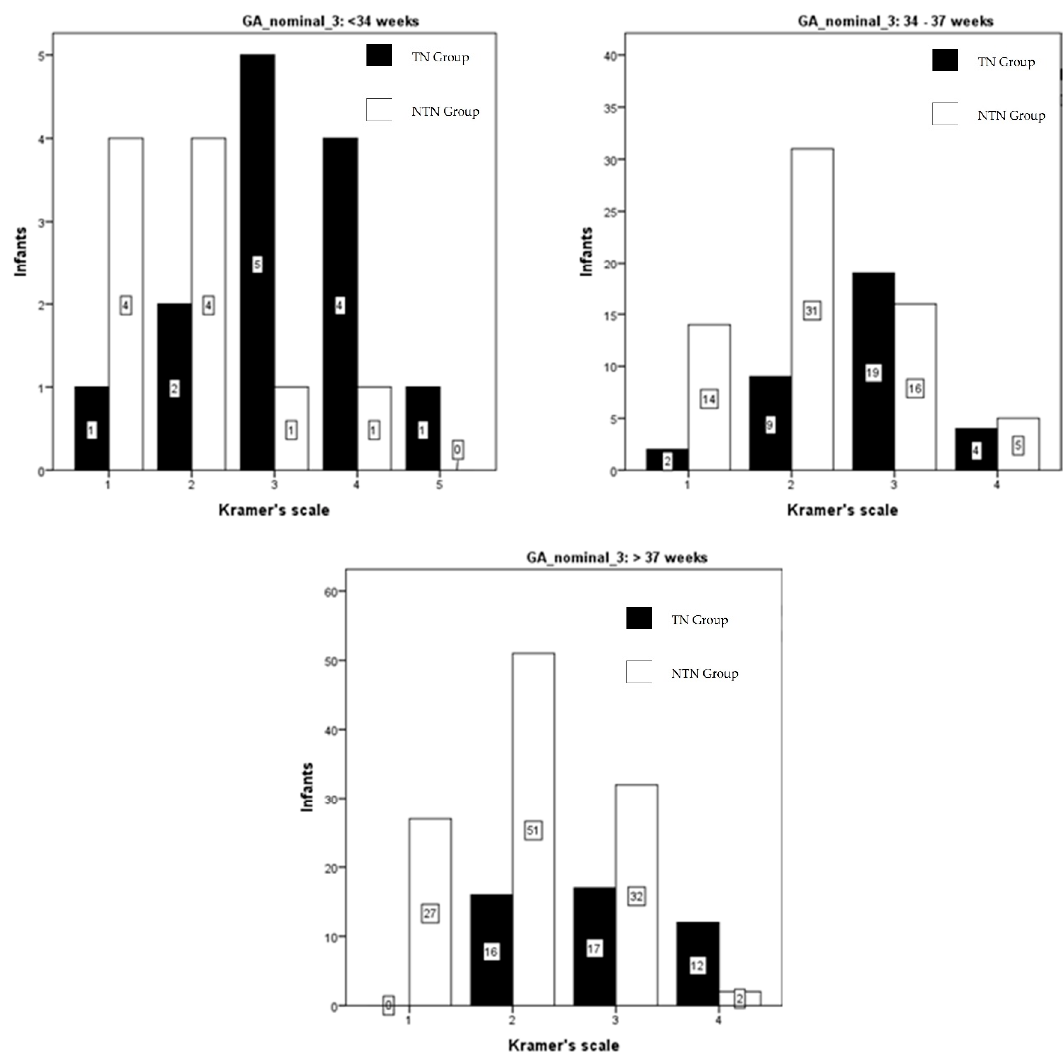
Figure 3. The number of infants needing phototherapy for each Kramer score in relation to gestational age. Black Bars infants who needed therapy (TN group); white bars infants where phototherapy was not indicated (NTN group).